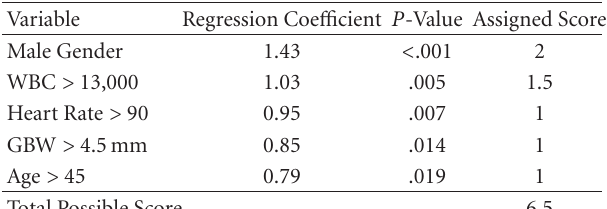
Table 4: Clinical score assignment by regression coe ffi cient.